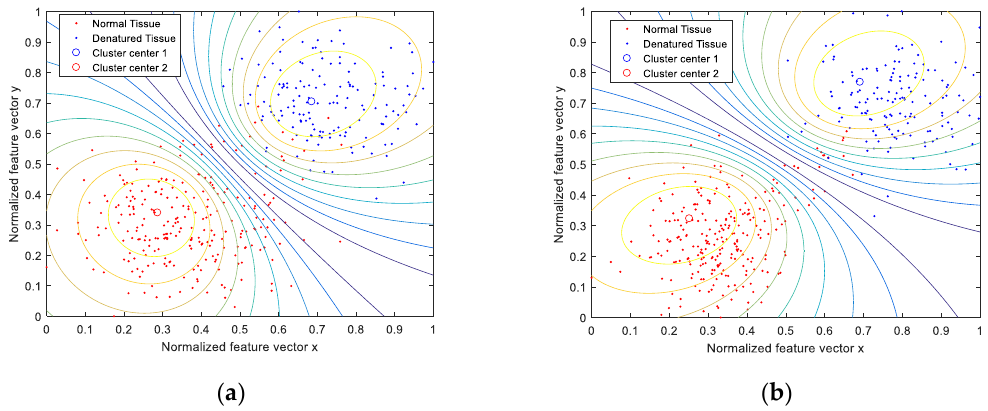
Figure 6. Recognition of denatured and normal issue based on Gustafson – Kessel (GK) fuzzy clustering: ( a ) MPE-GK; ( b ) IMPE-GK.